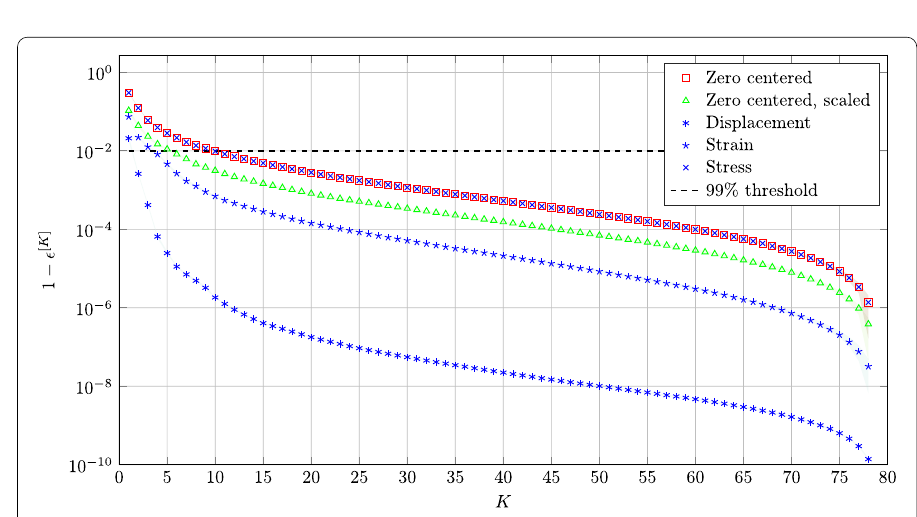
Fig. 5 Mean ratio of eigenvalues with 99% threshold over all training sets of the industrial bending problem. The shaded area represents the range over all training